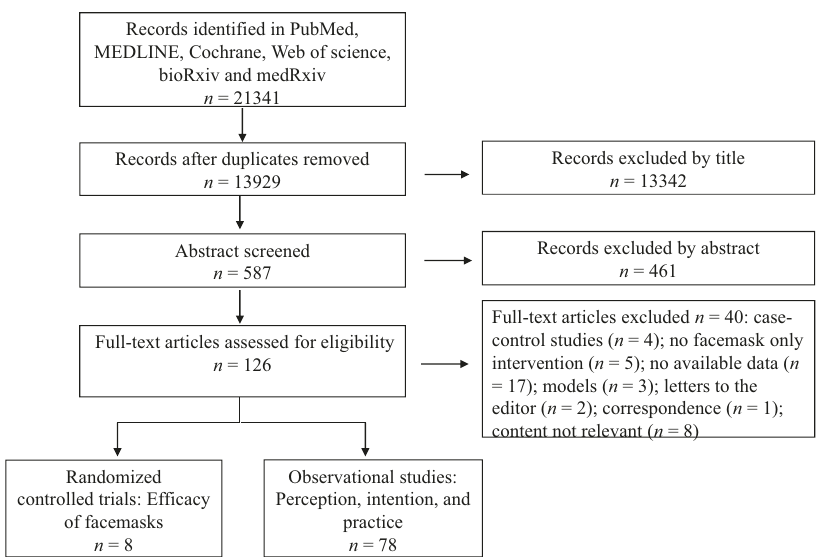
Fig. 1 Summary of the literature search and inclusion